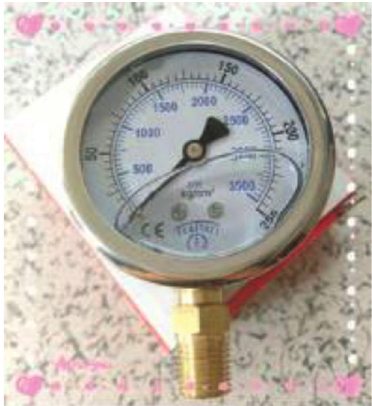
Figure 5: The photograph of oil pressure